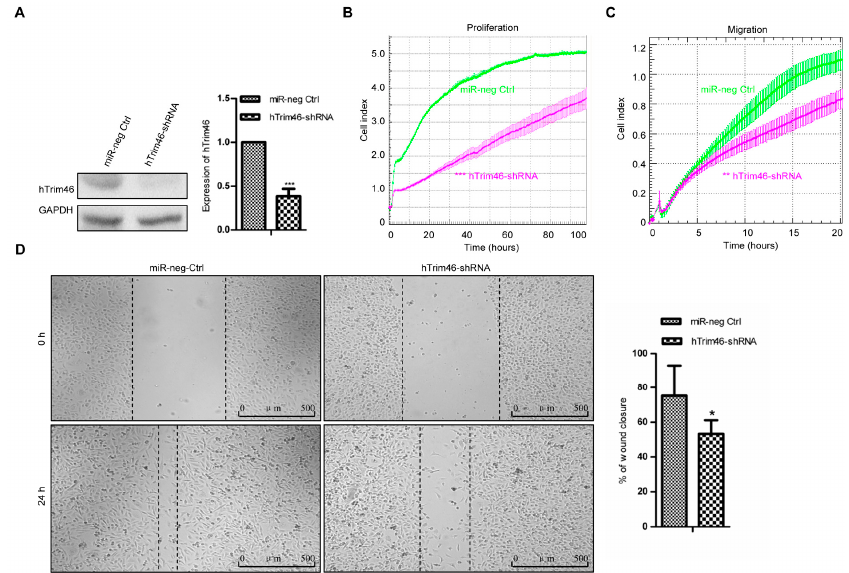
Figure 4. Knockdown of h-Trim46 inhibited cell proliferation and migration. ( A ) The expression of Trim46 was determined by western blot in the h-Trim46-shRNA stable expression MDA-MB-231 cells. GAPDH was used for normalization. *** indicates p < 0.001 versus control; ( B ) Cell proliferation in real time was analyzed by the xCELLigence RTCA. Shown are cell index values measured over 96 h. Error bars indicate standard deviations. *** indicates p < 0.001 versus control; ( C ) Cell migration in real time was analyzed by the xCELLigence RTCA. Shown are cell index values measured over 15 h. Error bars indicate standard deviations. ** indicates p < 0.01 versus control; and ( D ) A scratched-wound healing assay was performed in MDA-MB-231 cells with stable expression of h-Trim46-shRNA or negative control followed by photography at 0 h and at 24 h after the scratch. The statistical results are shown in the right panel. * indicates p < 0.05 versus control. Scale bar = 500 μ m.